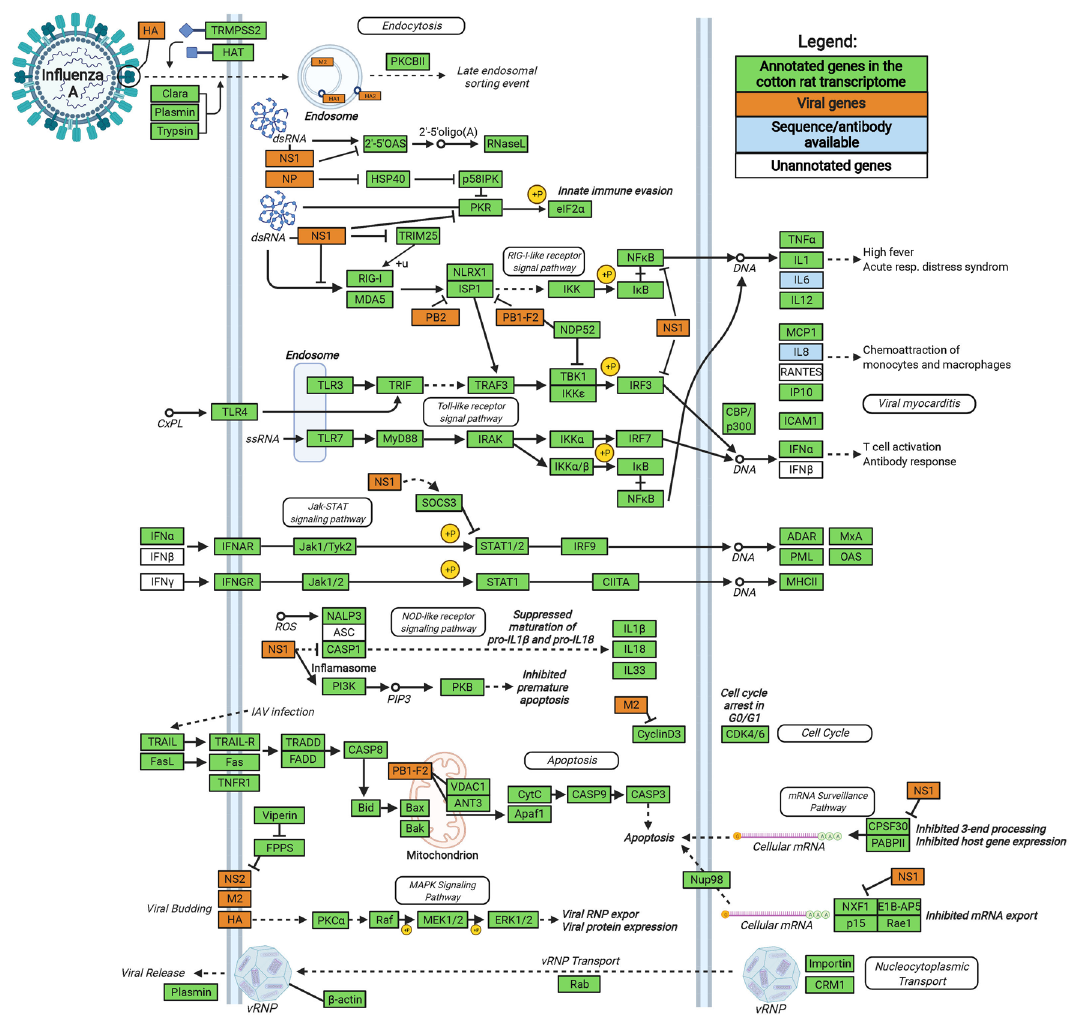
Figure 3. The Influenza Disease Pathway (adapted from Kyoto Encyclopedia of Genes and Genomes [KEGG]). 99 of the 105 essential genes of influenza pathogenesis were successfully assembled and annotated in our de novo transcriptome of S. fulviventer and S. hispidus . Created with